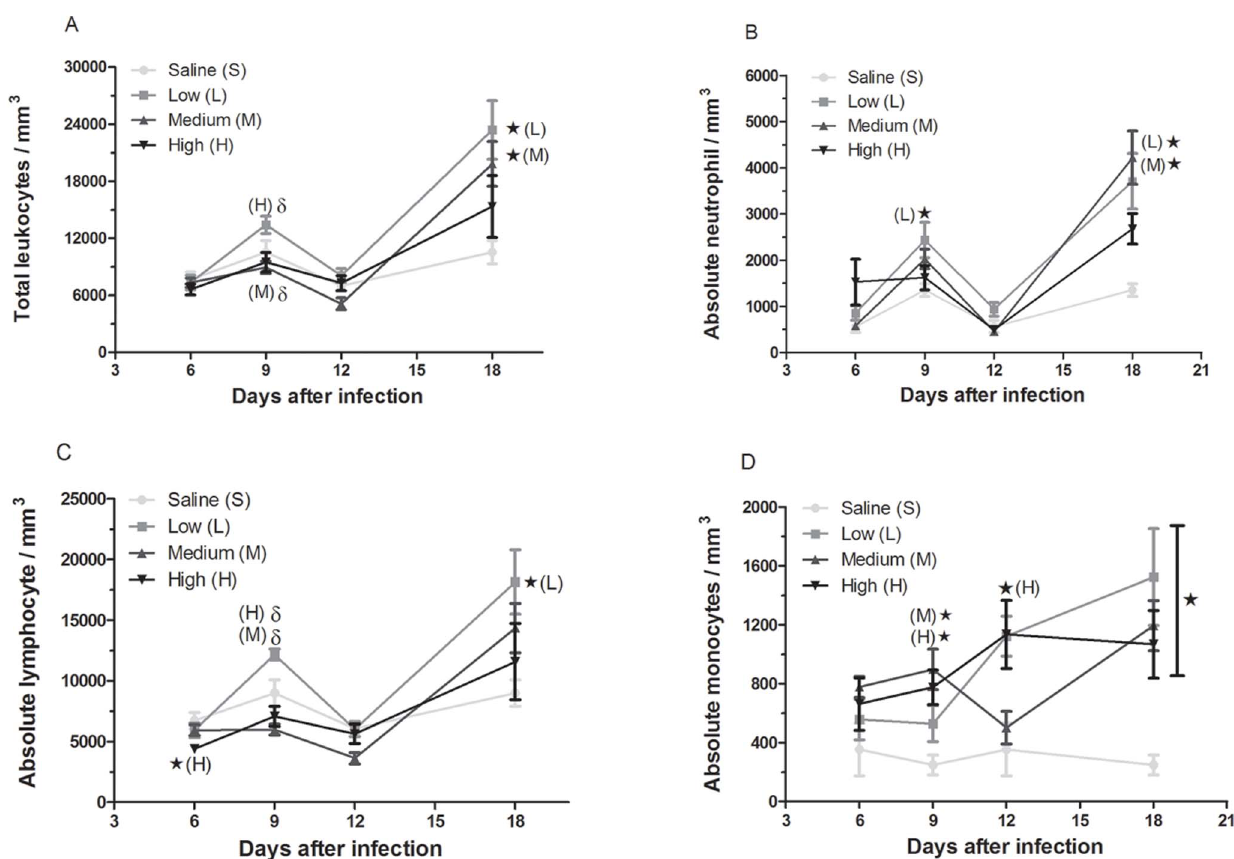
Figure 5. Increased circulating cells in mice infected with T.cruzi . C57BL/6 mice were infected with increasing doses of trypomastigotes, and at 6, 9, 12 and 18 days post-infection the number of cells/mm 3 in the blood was determined. At each time point, the total leukocytes (A), neutrophils (B), lymphocytes (C), and monocytes (D) were measured. Total cells were counted using a Neubauer chamber, and the differential cell counts (100 cells total) were obtained using stained blood smear slides. The data are reported as the means 6 SEM of 10 mice. *p , 0.05 versus the uninfected group.